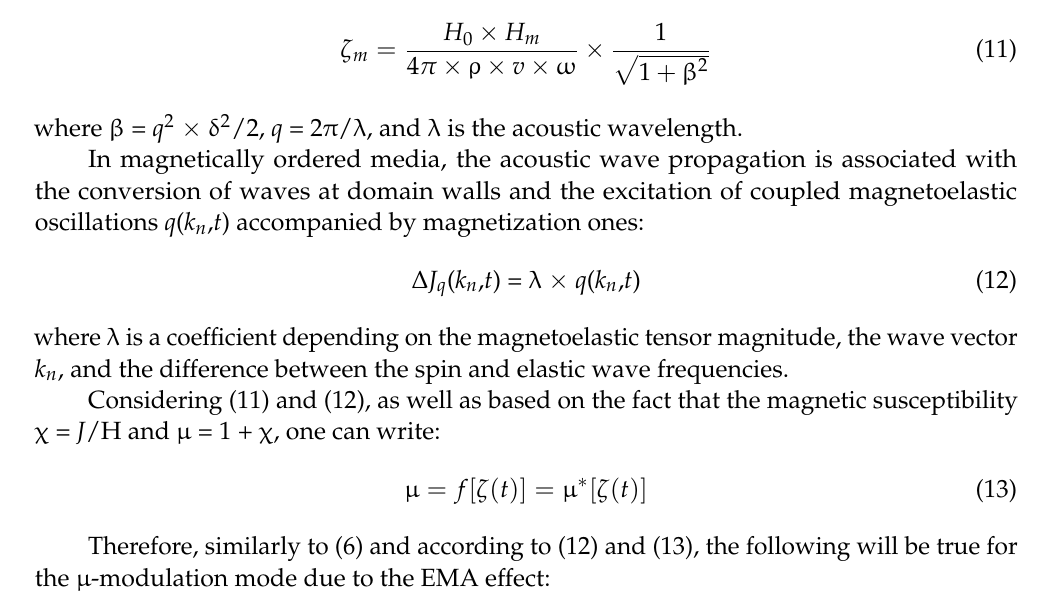
Figure 3. Model of the Radial Longitudinal Wave (L-Wave) Propagation over the Cylinder Cross-Section. At the distances exceeding the skin layer thickness, considering (8), the solution for Equation (9) will take the